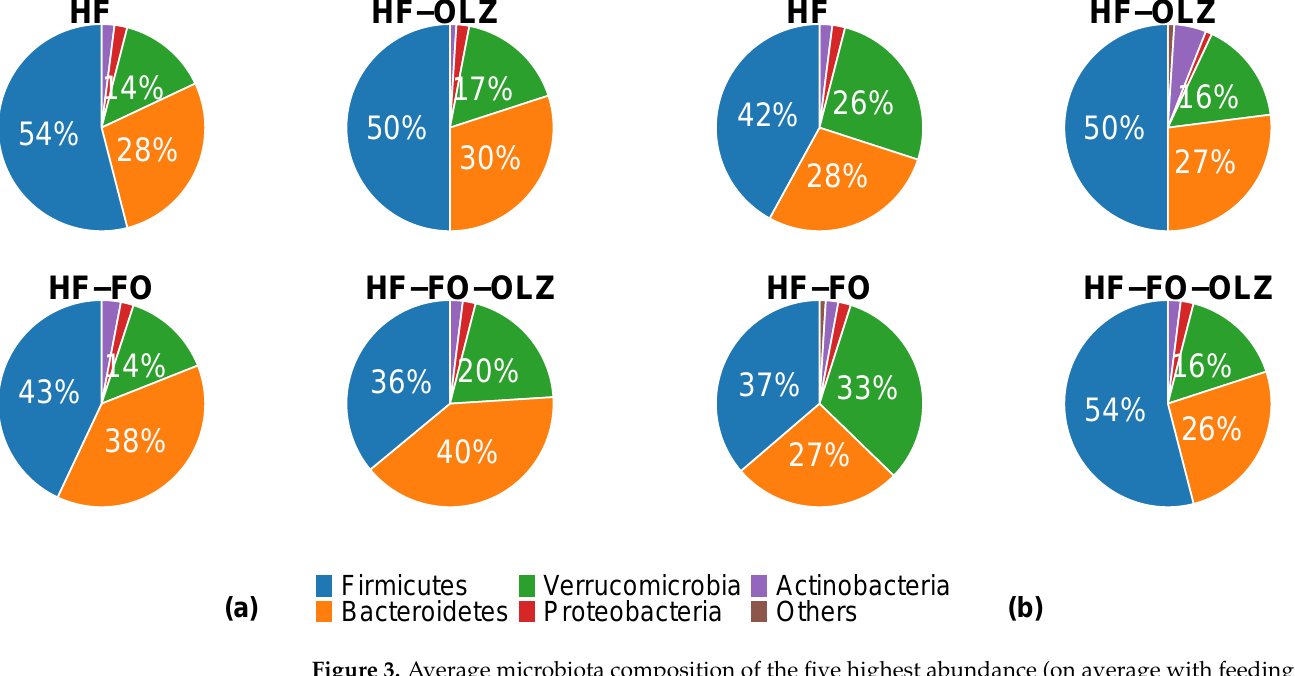
Figure 3. Average microbiota composition of the five highest abundance (on average with feeding group) OTUs at phylum level in the different feeding groups: ( a ) male, ( b ) female. Only major taxonomic groups are shown. Others represent the rest of the OTUs at phylum